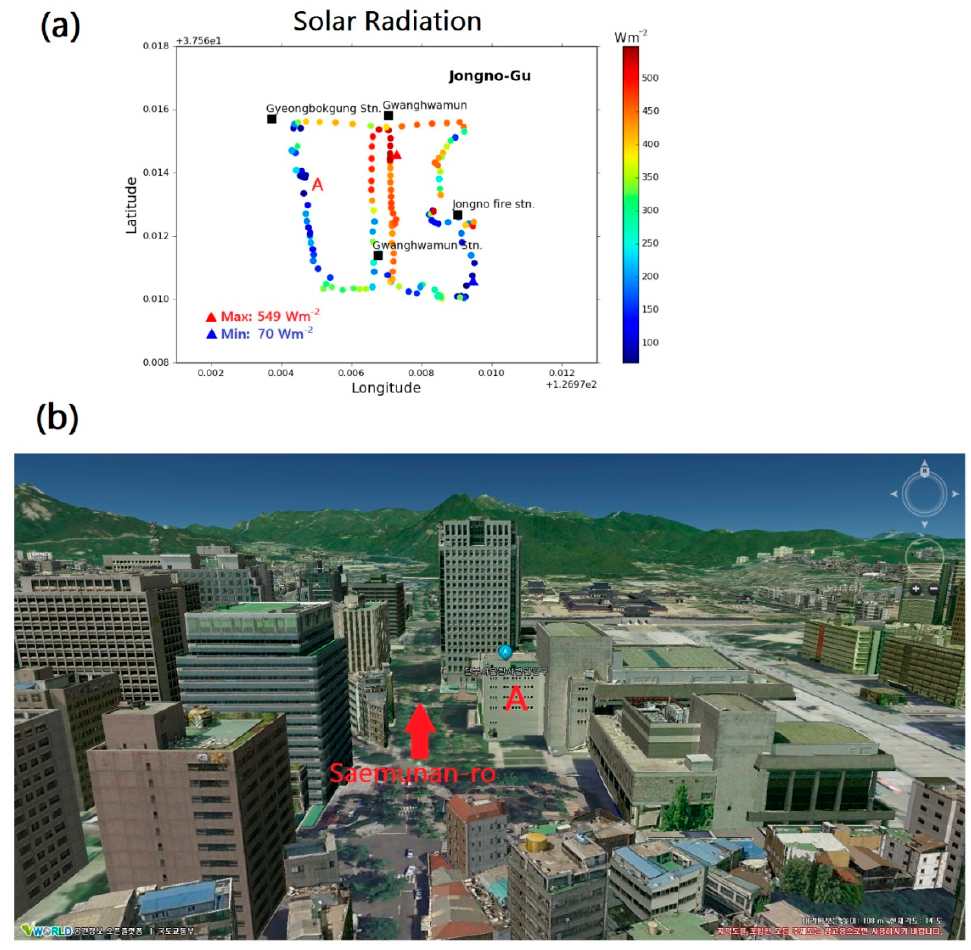
Figure 7. ( a ) Spatial distribution of solar radiation from MOVE observation during the daytime (1547–1602 LST) on 6 August, 2019, and ( b ) a 3D map view in the section of Saemunan-ro 5-gil from Vworld web service.